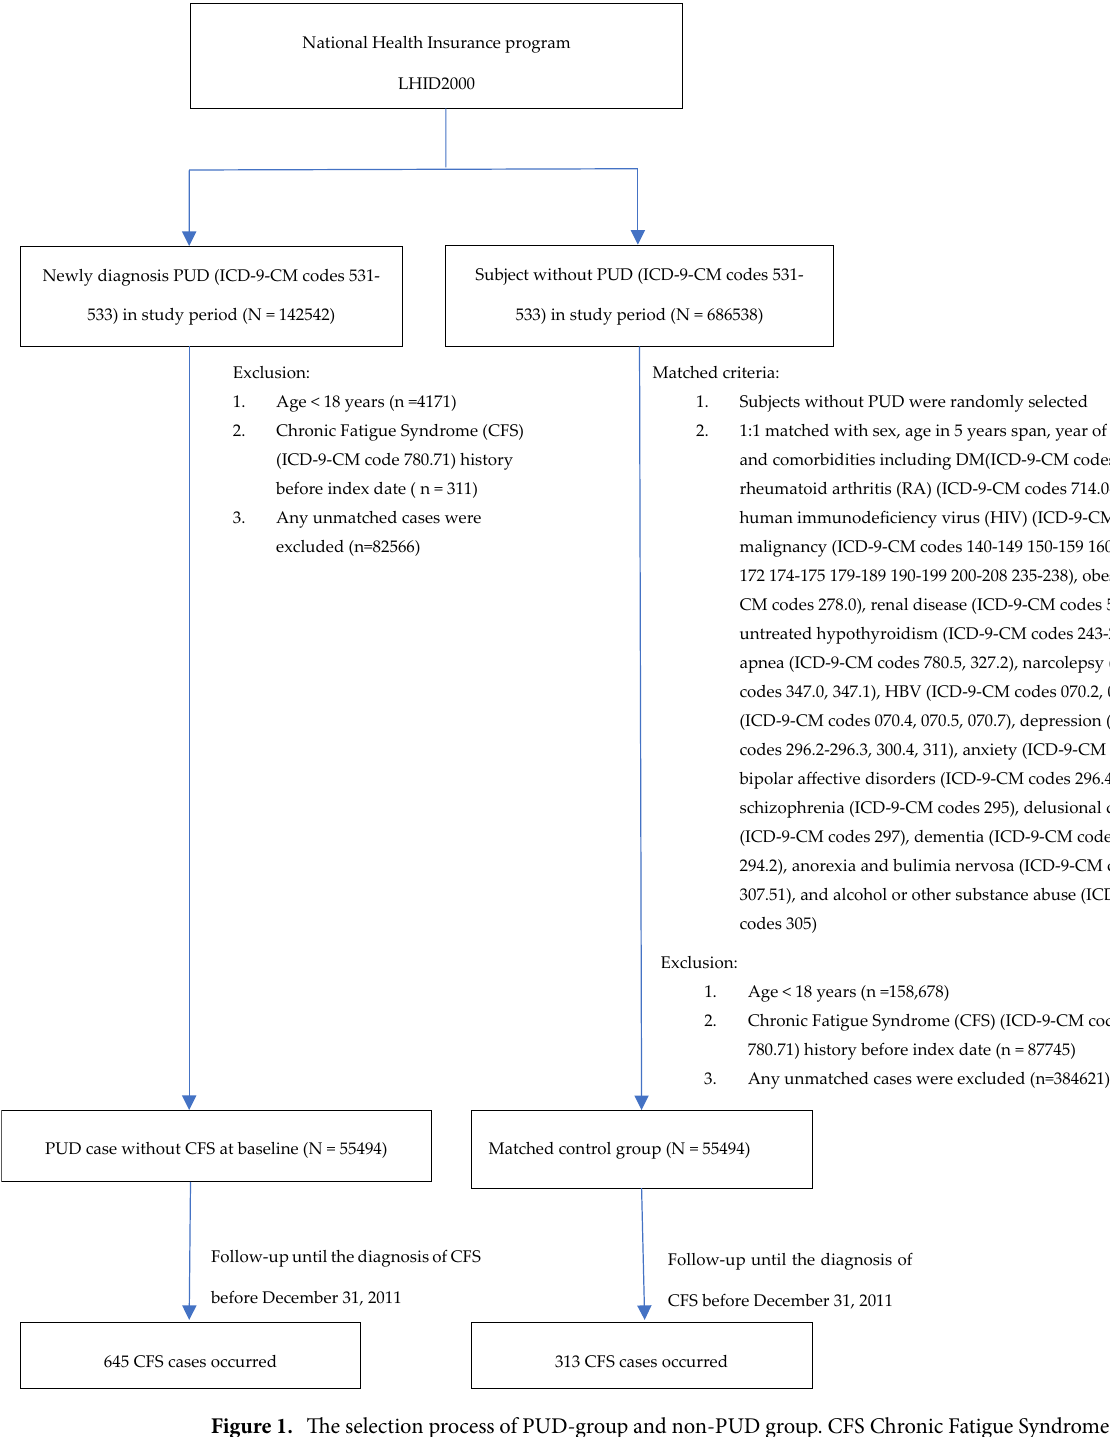
Figure 1. The selection process of PUD-group and non-PUD group. CFS Chronic Fatigue Syndrome, PUD Peptic Ulcer Disease, LHID National Health Insurance Research database, ICD-9-CM International Classification of Diseases, Ninth Revision, Clinical